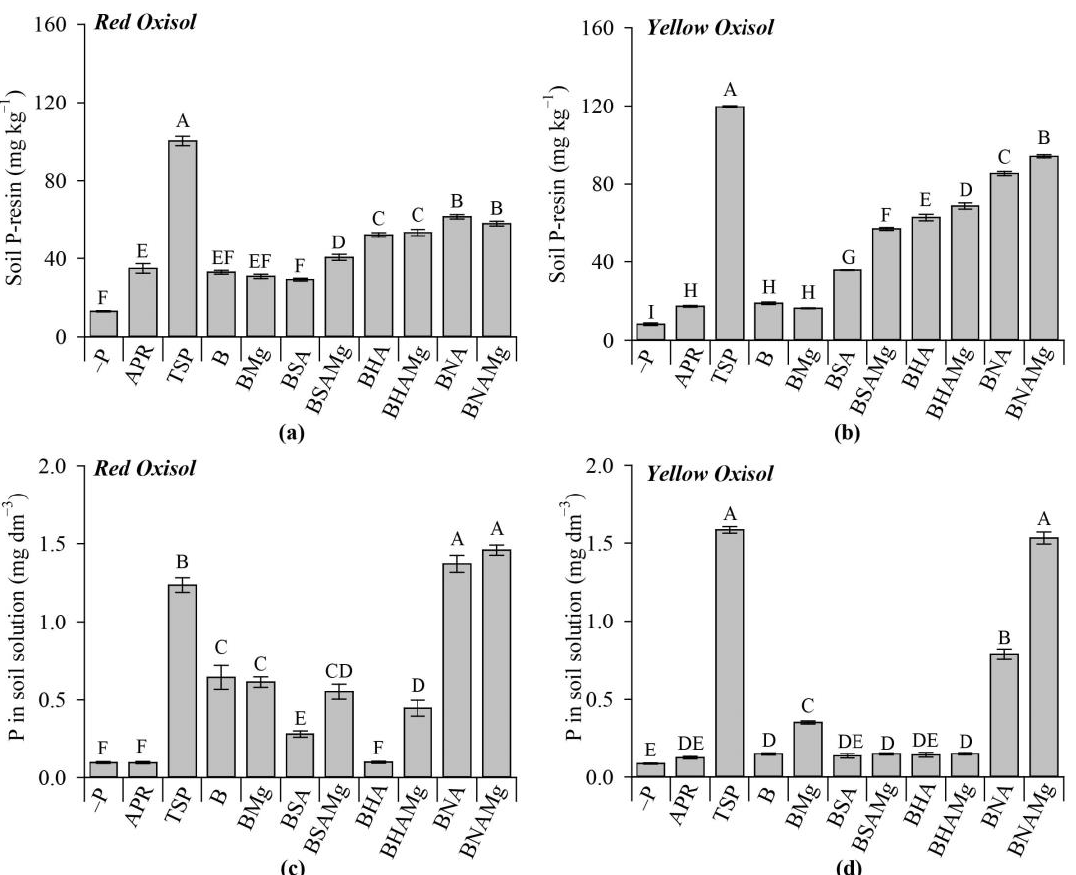
Figure 5. The resin soil test assessed available Phosphorus (P) in whole soil ( a , b ) and P in soil solution ( c , d ), for maize grown in the Red and Yellow Oxisols. Bars with standard error followed by the same letter did not differ regarding the treatment means, according to the Duncan test ( p < 0.05). –P: no P fertilizer supplied to plants; TSP: triple superphosphate; APR: Araxá phosphate rock. More details of the BBFs acronyms and synthesis routes are shown in Table 1.